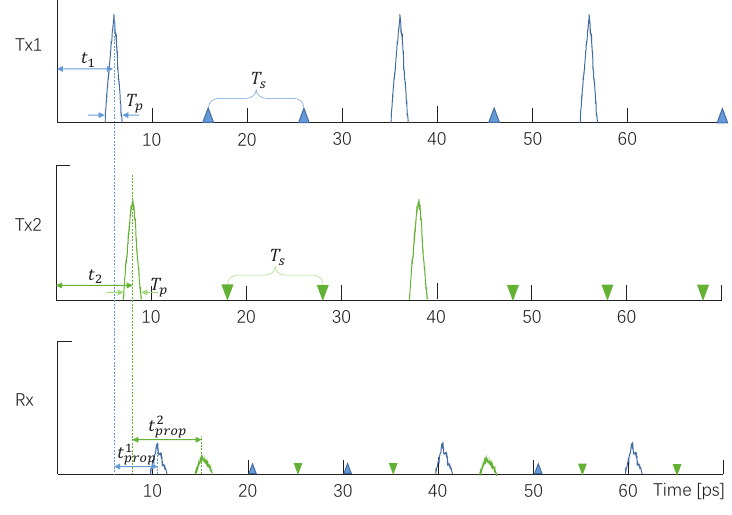
Figure 1. Examples of TS-OOK modulation